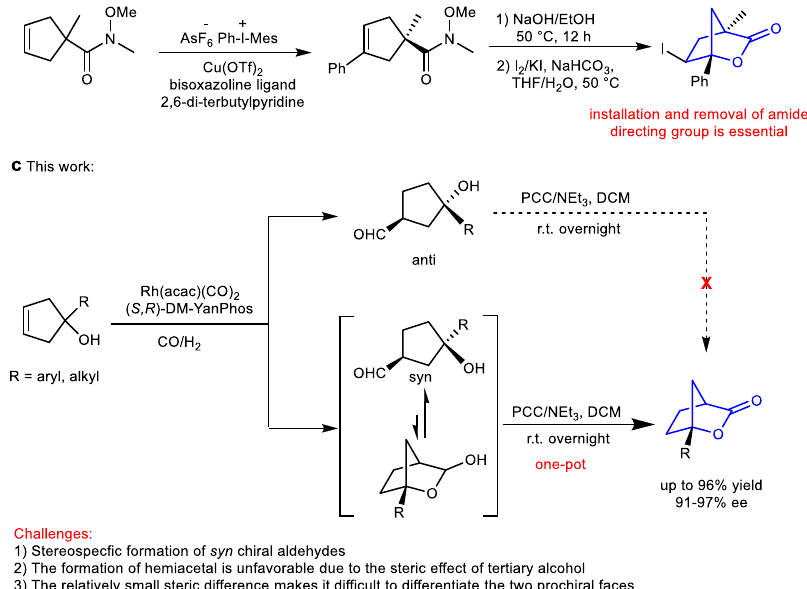
Fig. 2 Methods for synthesis of chiral bridged [2,2,1] bicyclic lactones. a Synthesis of bridged [2,2,1] bicyclic lactones by using chiral alcohol as starting material. b Preparation of bridged [2,2,1] bicyclic lactones by amide-directed Heck reaction and iodolactonization. c Stereopeci fi c hydroformylation and lactonization to form bridged [2,2,1] bicyclic lactones.